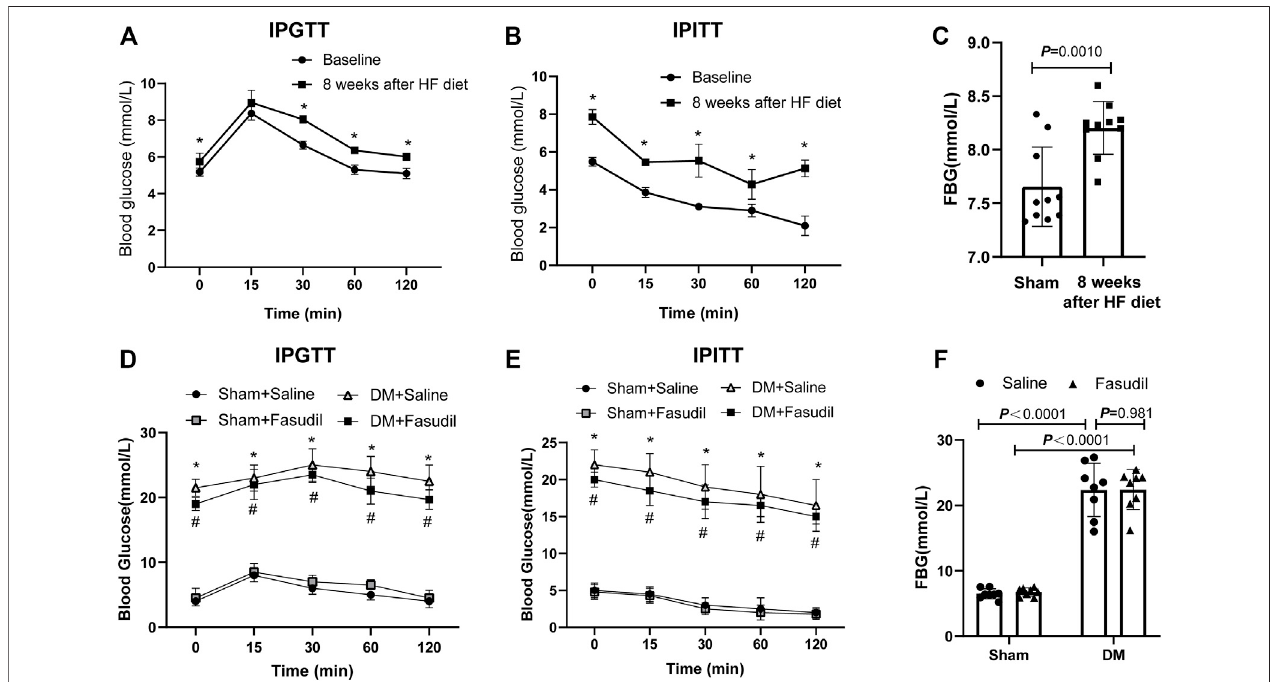
FIGURE1| Establishmentoftype2diabetesmodelofmice (A – C) 6to8 weekoldmalec57micewerefedhighfatdietsfor8weeksandshowedinsulinresistance. Intraperitonealglucosetolerancetest(IPGTT),intraperitonealinsulintolerancetest(IPITT),andFastingbloodglucose(FBG)wereperformedatbaselineandatweekeight in the DM group (n = 8 – 10); After 8 weeks of an HF diet, mice with insulin resistance were administered with STZ (i.p.). At the end of experiment, the pathologies of the mice were identi fi ed using the following tests (D) IPGTT (E) IPITT (F) FBG. p -values were adjusted for comparisons of multiple means. * p < 0.05, ** p < 0.01 vs. the Sham + Saline group. # p < 0.05, ## p < 0.01 vs. the DM + Saline